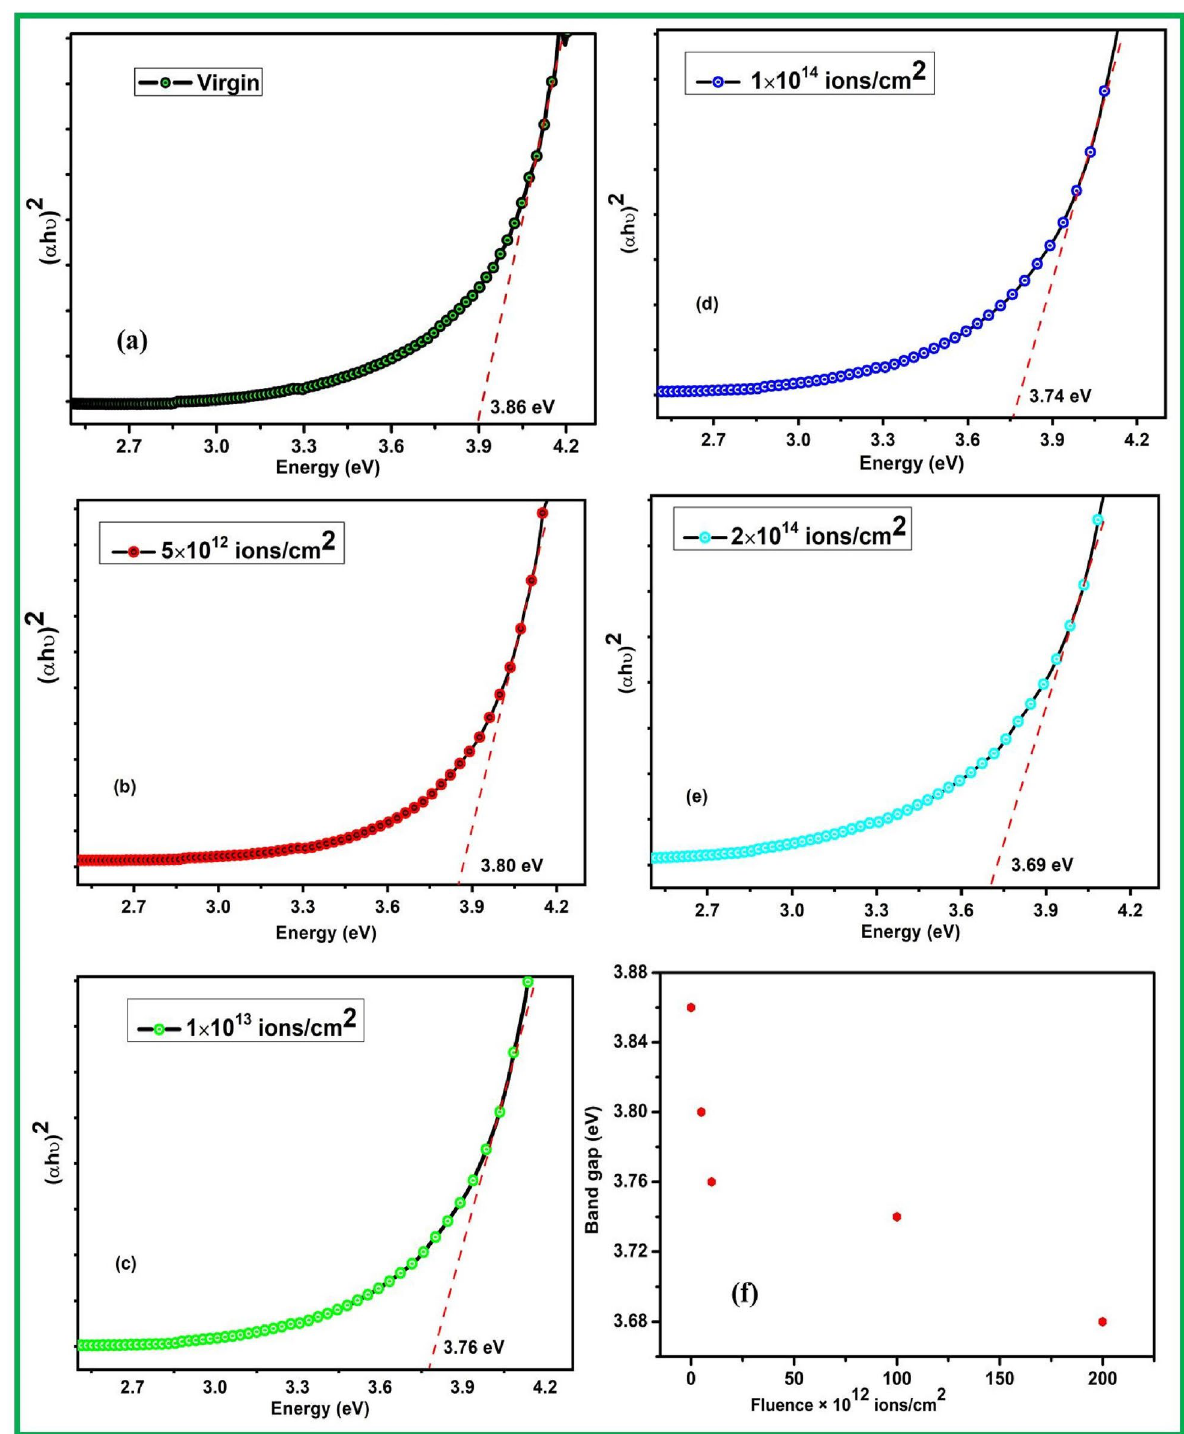
Figure 6. Ni 7+ ion beam irradiated ZrO 2 thin films shows the band edge of ZrO 2 in all samples and Tauc’s plot with optical band gap energy of ( a ) Virgin, ( b ) 5 × 10 12 , ( c ) 1 × 10 13 ( d ) 1 × 10 14 and ( e ) 2 × 10 14 ions/cm 2 ( f ) plot of band gap values of virgin and irradiated